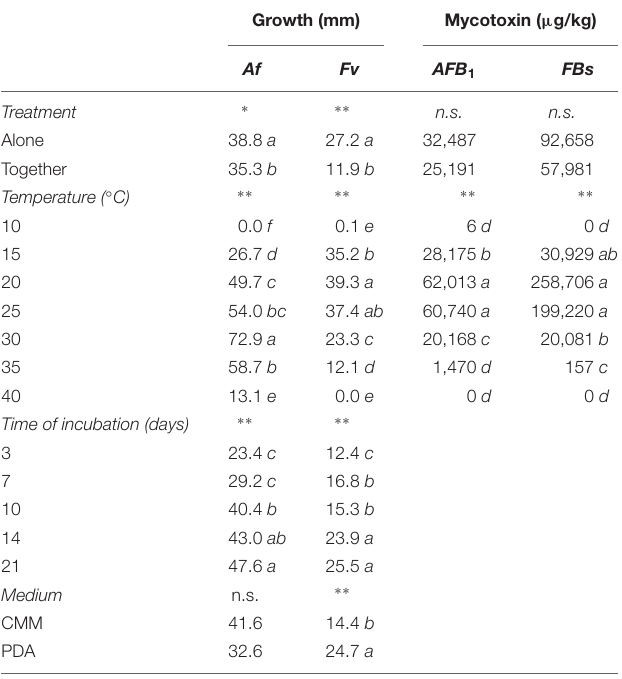
TABLE 1 | Analysis of variance (ANOVA) of Aspergillus flavus ( Af ) – Fusarium verticillioides ( Fv ) growth (mm) and aflatoxin B 1 (AFB 1 ) and fumonisin B 1 + B 2 (FBs) contamination ( µ g/kg) in the different treatments considered (fungi grown alone or together), temperature (10–40 ◦ C, step 5 ◦ C), time of incubation (3, 7, 10, 14, and 21 days) and medium (CMM or PDA).